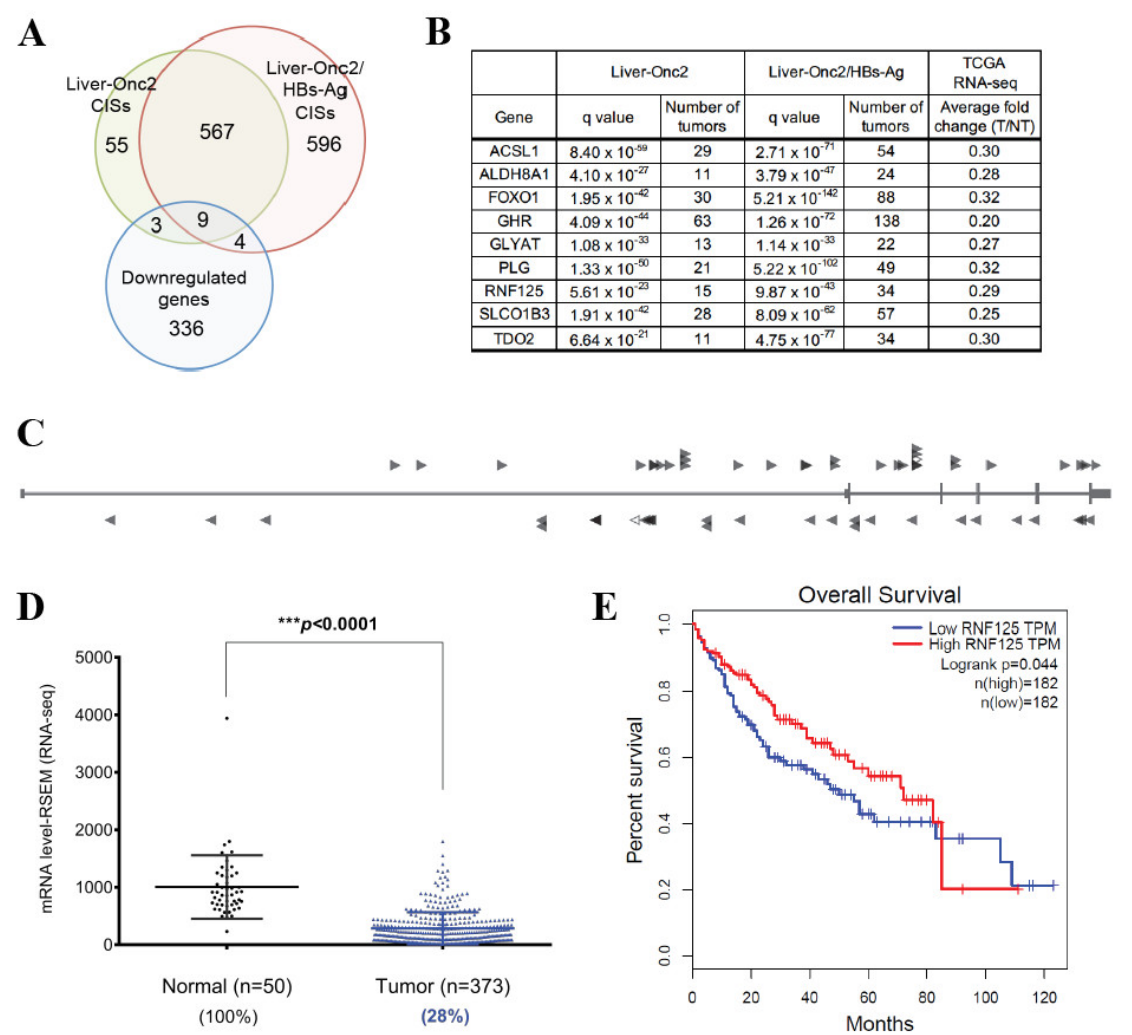
Figure 1. RNF125 is a candidate tumor suppressor and significantly downregulated in human HCC. ( A ) Cross-species comparison among stringent CISs of tumors from Alb-Cre/+; T2Onc2/+; Rosa26- lsl-SB11/+; HBs-Ag/+ mice (Liver-Onc2/HBsAg mice) and those from Liver-Onc2 mice, and genes with more than 3-fold downregulation of mRNA abundance in human HCC. ( B ) Nine common genes. ( C ) Pattern of Sleeping Beauty transposon insertions indicated that RNF125 is a tumor suppressor. ( D ) RNF125 is significantly downregulated in human HCC. ( E ) Low expression levels of RNF125 are associated with poor patient survival in HCC.